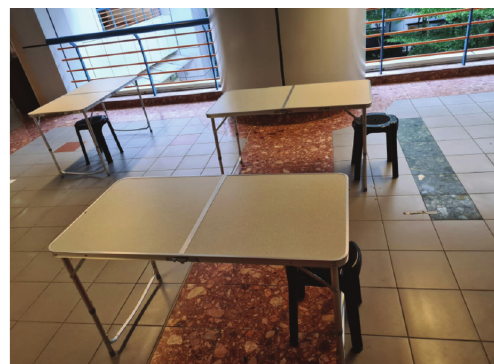
Further segregation measures during mealtimes in public Fig. 3: areas to maintain social distancing.